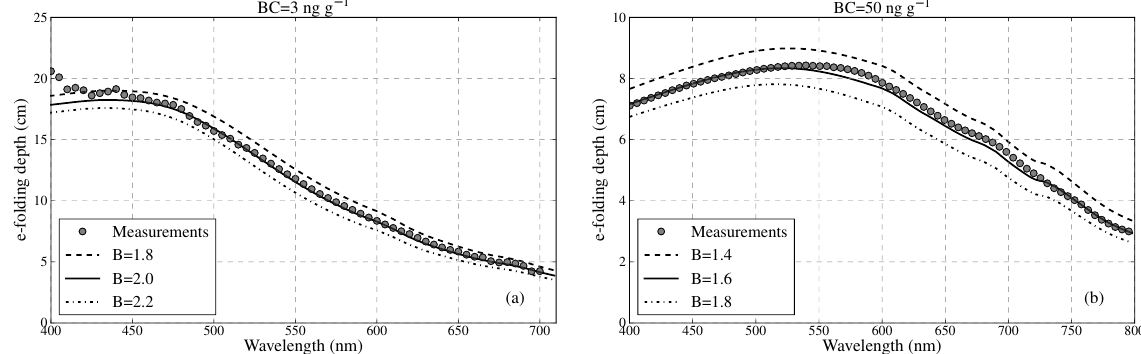
Fig. 5. (a) Spectral e -folding depth measured between 24cm and 42cm in the depth hoar layer at Dome C (29 Dec 2009). Modelled spectral e -folding depths are also shown for different values of B . (b) Spectral e -folding depth measured between 7 . 5cm and 23cm at Lac Poursollet (10 May 2012) in a snowpack composed of coarse grains.